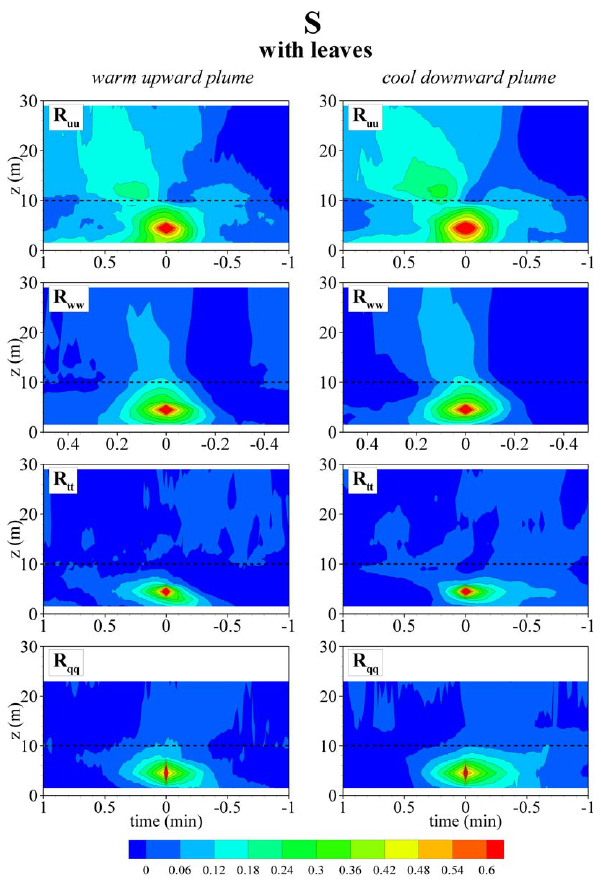
Fig. 11. Autocorrelation contours of u ( R uu ), w ( R ww ), t ( R tt ) and q ( R qq ) associated with warm upward and cool downward plumes referenced to the middle canopy ( Z = 4 . 5m) and T = 0min, for the stable regime (S) and for the period with leaves. The autocorre- | 1 3 | 1 lations correspond to R 1 ϕϕ and R ϕϕ in Eq. (10), where ϕ is either u , w , t or q . Negative times correspond to times before the structure detection (downwind condition) and positive times to times after the structure detection (upwind condition). The dashed line indicates the canopy